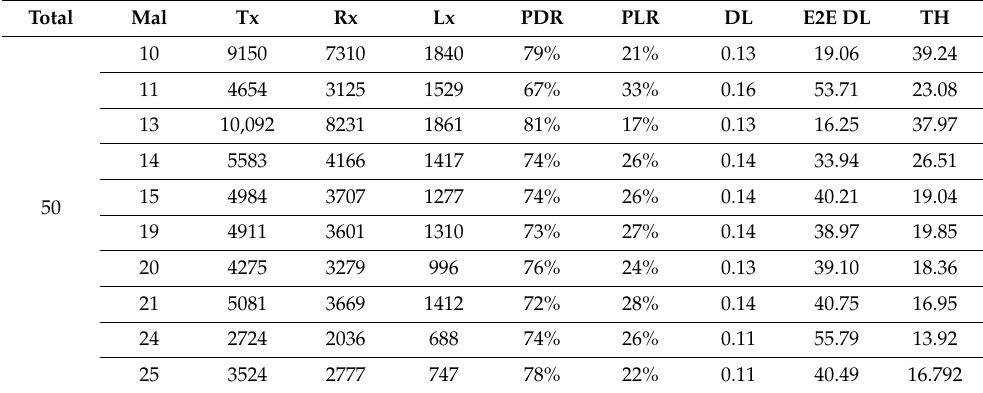
Table 6. Comparative Analysis of the Number of Malicious Nodes in Mobile